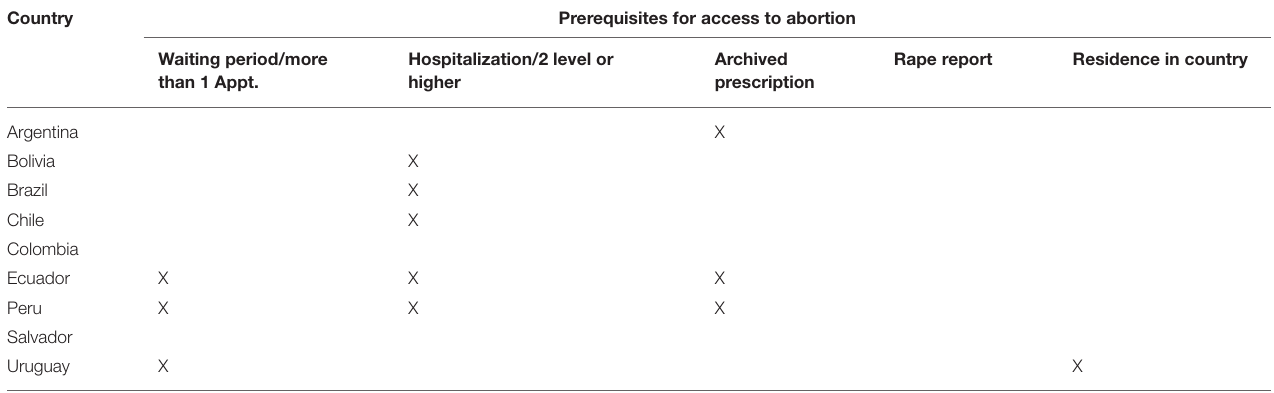
TABLE 7 | Prerequisites for access to abortion previous to the pandemic. Country Prerequisites for access to abortion Waiting period/more than 1 Appt.